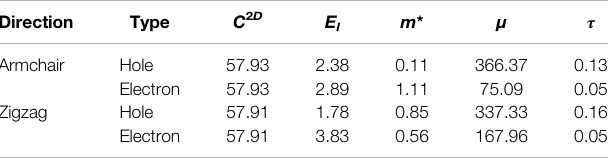
TABLE 1 | Calculated lattice constants ( l a ), bond lengths of P – P ( l P – P ) and X – P ( l